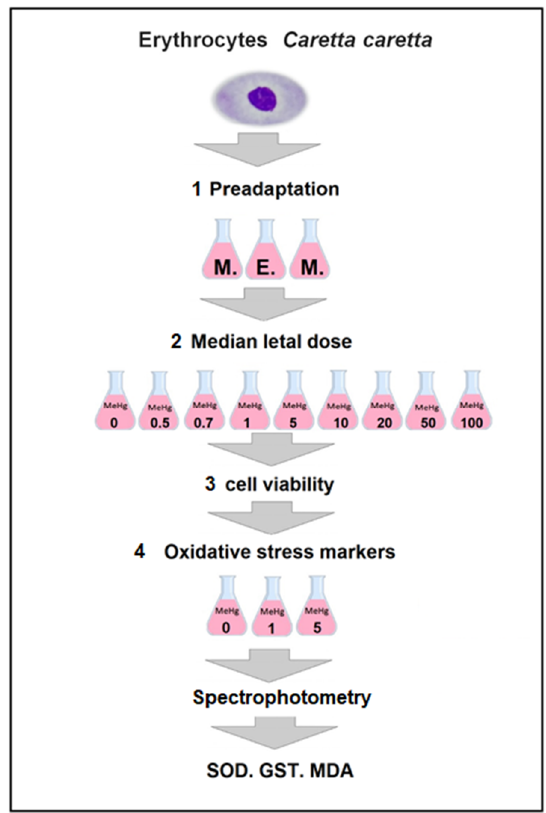
Figure 1. Experimental design. The loggerhead sea turtle erythrocytes were subjected to 1. Pre-adaptation in supplemented Minimum Essential Medium (MEM) medium, 2. Determination of LC 50 in nine doses of methyl mercury, 3. Cell viability determination and 4. The erythrocytes were subjected to acute doses of methyl mercury and the activities of superoxide dismutase (SOD) and glutathione-s-transferase (GST) enzymes, and the Malonaldehyde (MDA) concentration were measured for spectrophotometry.